Question: What form of chart is displayed?
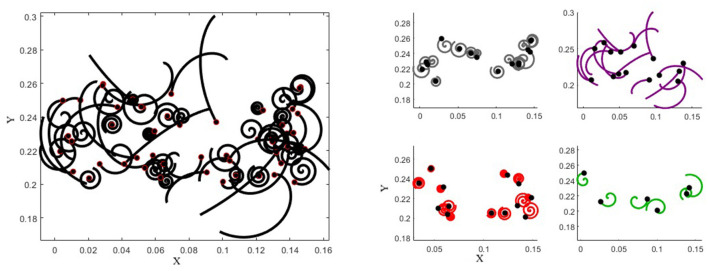
Answer: line